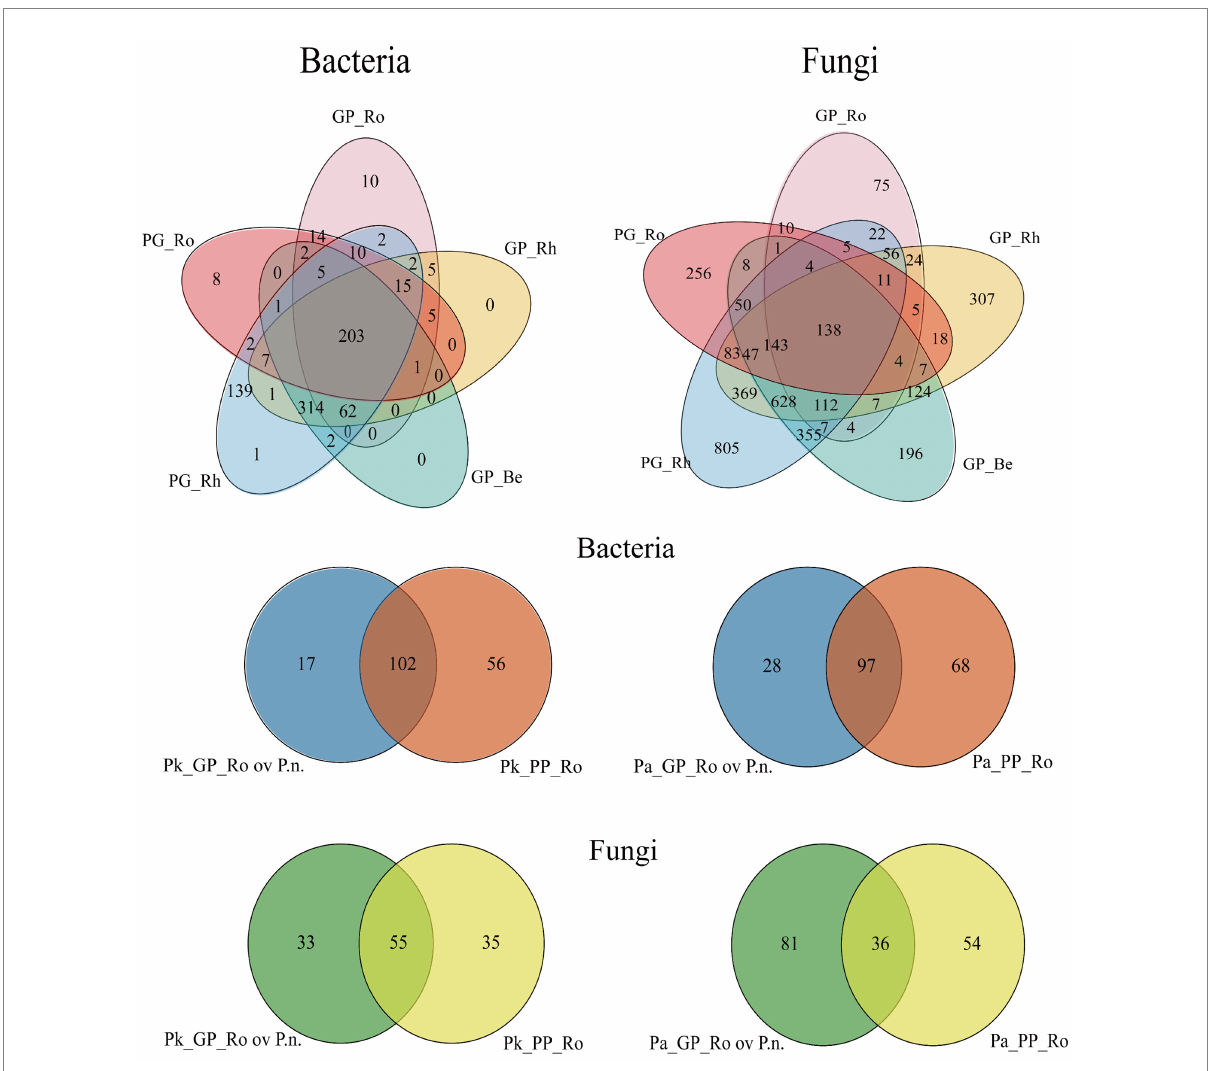
FIGURE 10 Venn diagram showing the overlap and possible transmission of colonies in the P.n .-pine agroforestry system. (Pk/Pa) GP_Ro, the pine root microbes of P.n. -( P.k. / P.a ) agroforestry system, (Pk/Pa) GP_Rh, the rhizosphere microbes of P.n. -( P.k. / P.a ) agroforestry system, GP_Be, the middle of the planting P.n. and adjoining pine tree, PG_Rh, the P.n. rhizosphere microbes, PG_Ro, the endosphyte of P.n. root. Pk(Pa)_GP_Ro ov P.n. , Overlap of the endophytic microbes of P.k. ( P.a. ) roots with the endophyte of